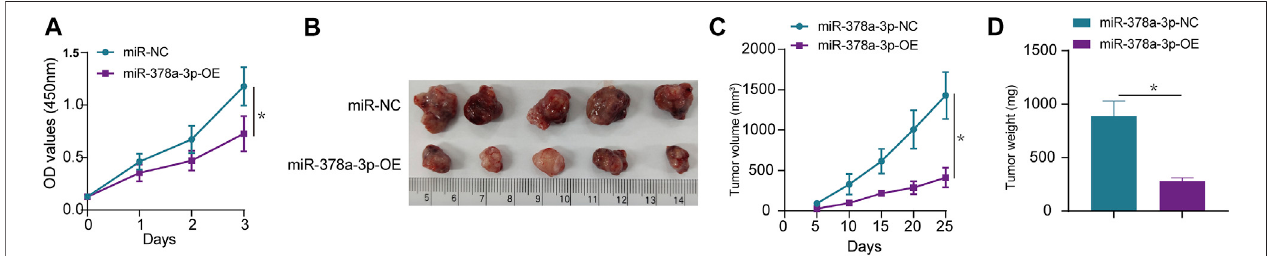
FIGURE 5 | miR-378a-3p inhibits MG63 cell proliferation in vivo and in vitro. (A) MG63 cells were transfected with control-mimic (miR-NC), miR-378a-3p-mimic (miR-378a-3p-OE), and then cultured under hypoxic conditions. Cell proliferation assay using CCK8 assay. (B – D) Tumor weight and volume were examined after mice were sacri fi ced, representative tumors from corresponding treatments groups. ( n (cid:1) 5). The data are presented as the mean ± SD. * p <